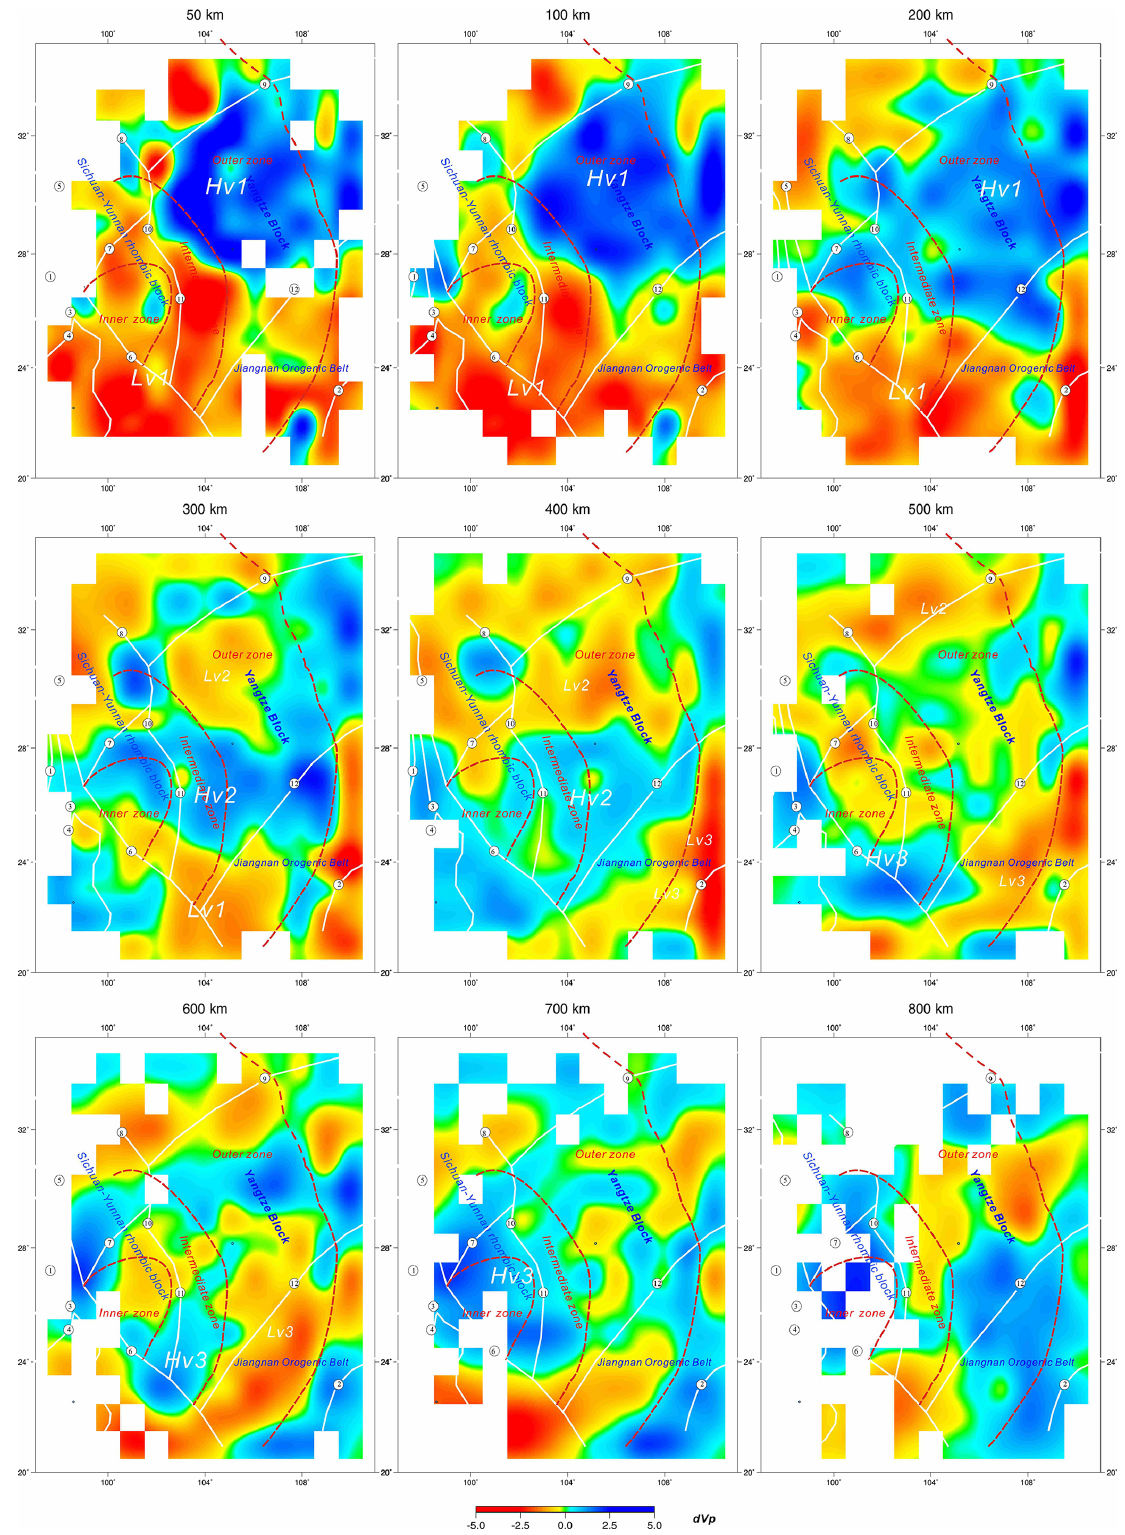
Figure 8. P-wave velocity perturbation at 50, 100, 200, 300, 400, 500, 600, 700, and 800km depth sections relative to the IASP91 1D velocity model (Kennett and Engdahl, 1991). Portions of the model where the recovery of the starting model in the CRT was below 20% are not shown (see Fig.